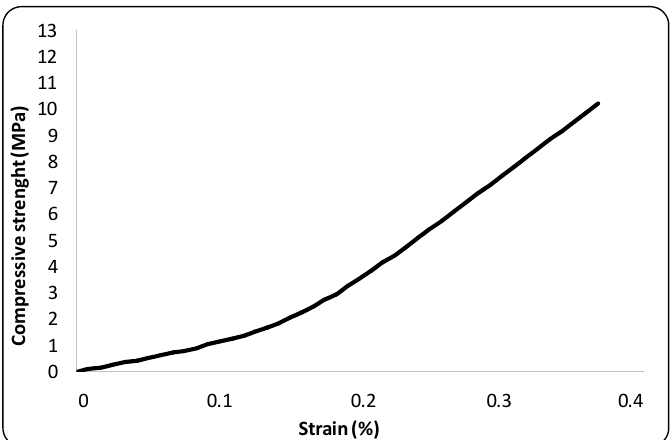
Table 6. Compressive strength tests results.